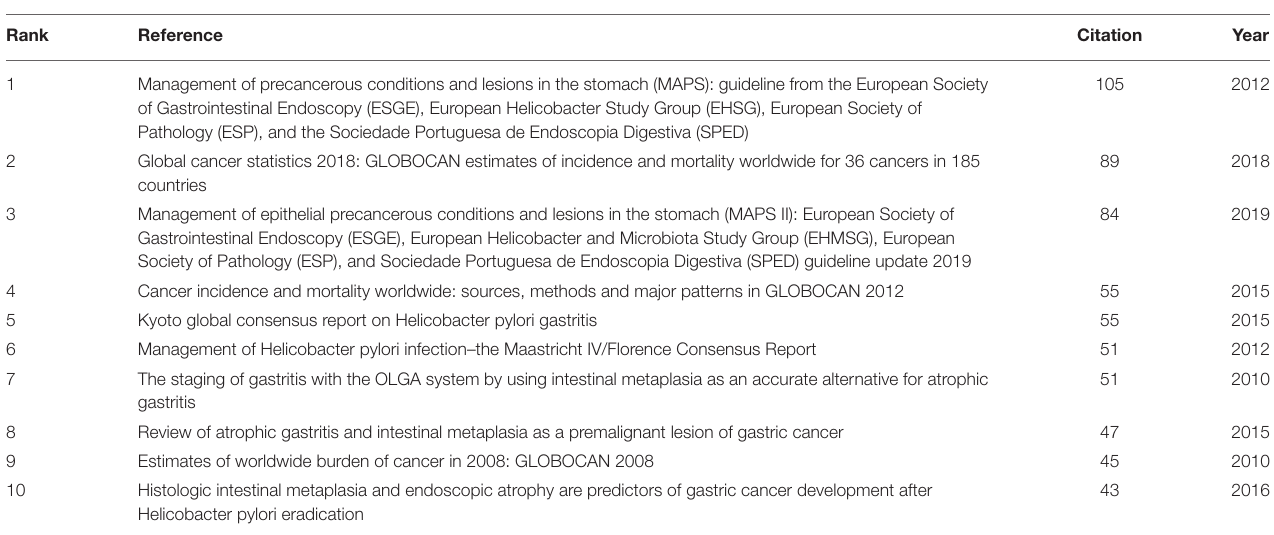
TABLE 4 | Top 10 co-cited references in AG research.